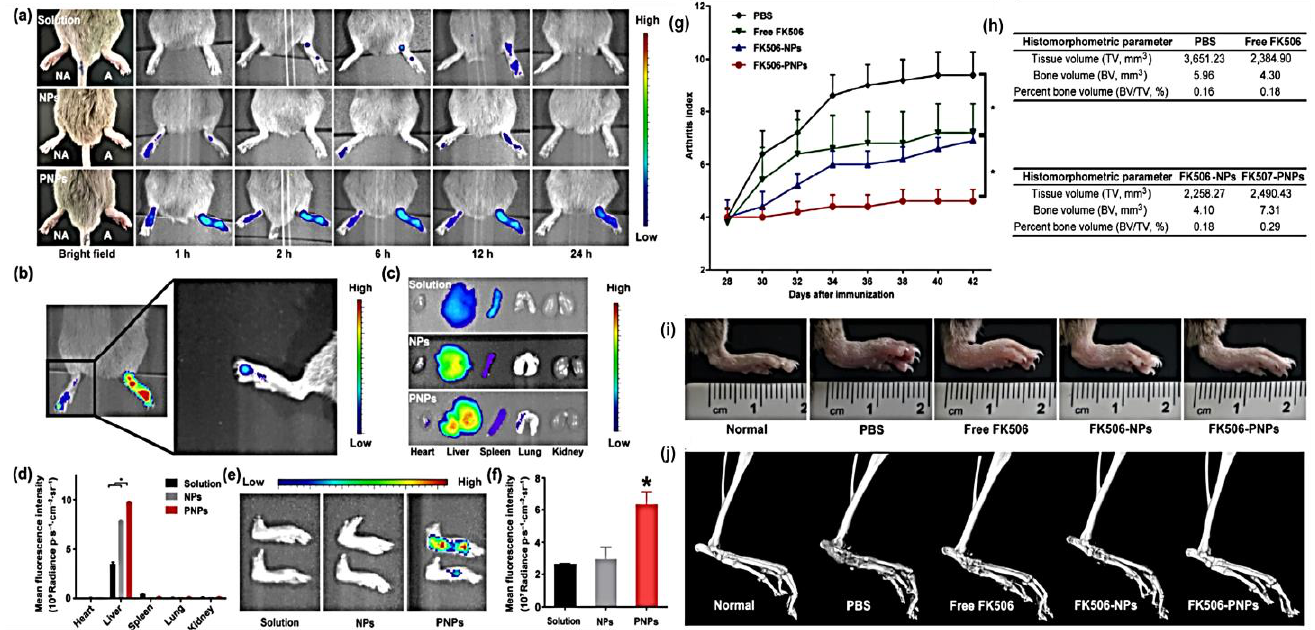
Figure 7. PNPs in vivo and ex vivo imaging in CIA mice. ( a ) NIRF imaging in vivo of arthritic (right) and non-arthritic (left) paws from CIA mice (n = 3) at various times following intravenous injection. ( b ) Inflamed right paw fluorescence images with only one arthritic toe. ( c ) NIRF imaging ex vivo of major organs after 24 h of nanoparticle injection. ( d ) Major organs mean NIRF intensity (n = 3; mean ± SD), p < 0.05 compared to a solution or the NP group. ( e ) Twenty-four-hour post-injection inflamed paws ex vivo NIRF image from the NP as well as PNP groups. ( f ) Paw inflammation intensity as measured by mean NIRF (n = 3; mean SD), * p < 0.05 vs. solution and NP groups. ( g ) CIA mice therapeutic efficacy. Average rheumatoid arthritis index as a function of the time since the first immun- ization. ( h ) Micro-CT data of hind paw quantitative analysis. ( i ) Hind paw representative pictures their hind paws, and the results were reconstructed in three dimensions. Adapted from [103] with permission under license